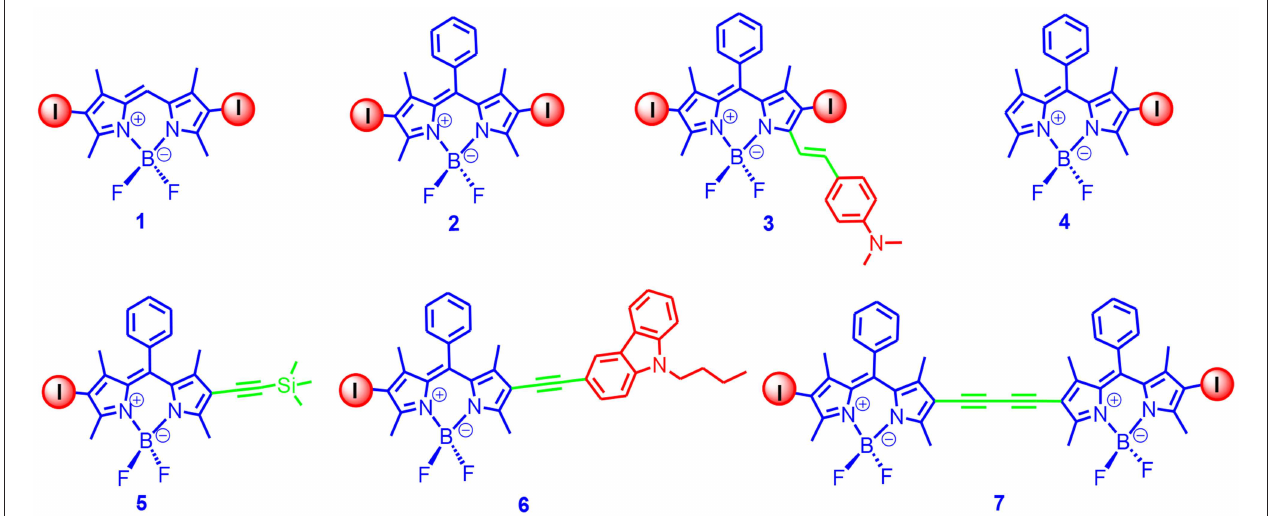
FIGURE 1 | Mono- and DiiodoBodipy derivatives showing variable absorption wavelengths and efficient